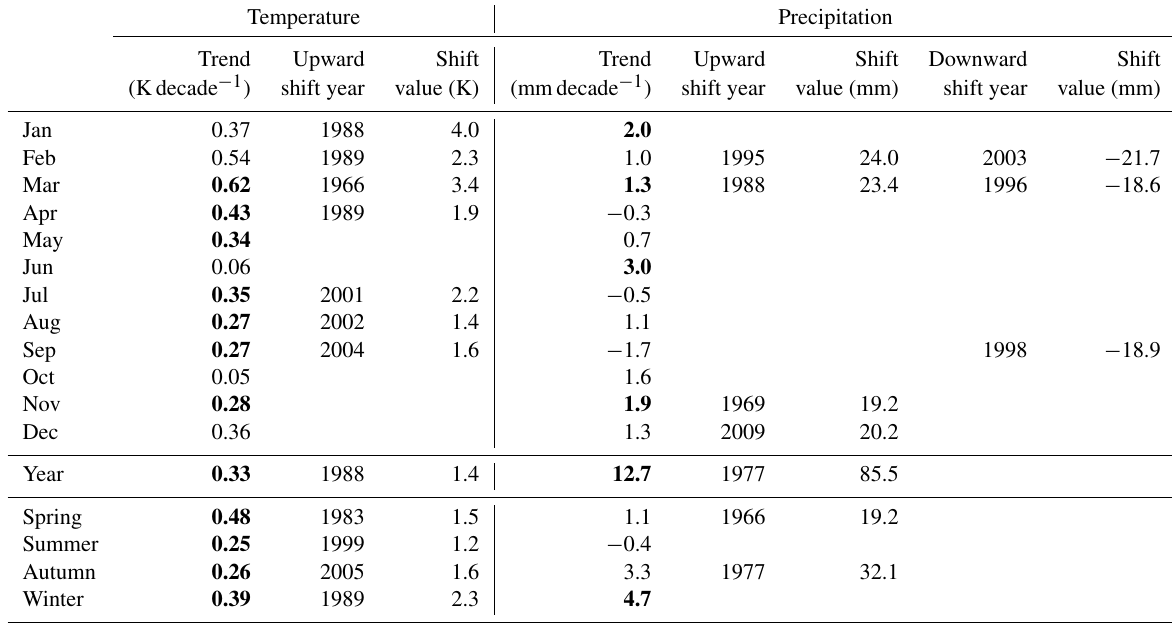
Table 4. Trend values, shift years and shift values of spatially averaged monthly, annual and seasonal mean air temperature and precipitation in Estonia during 1951–2015. Statistically significant trends on p <0.05 are in bold. A significant downward regime shift for temperature was detected only in January from 1966 by −